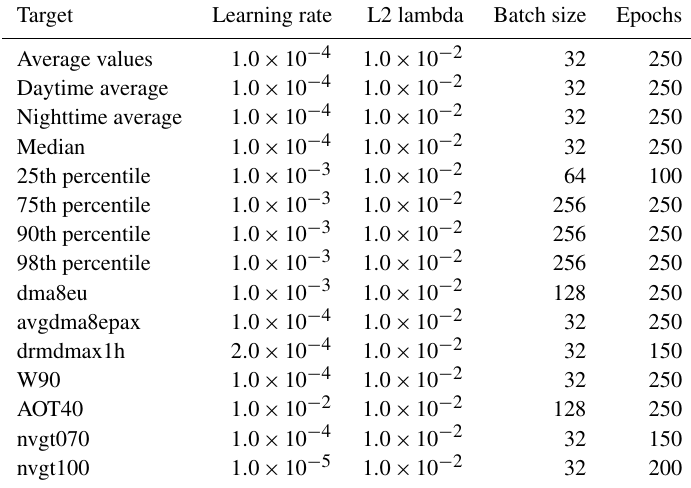
Table D1. Hyperparameters for the neural network training in Sect. 5.3. They are determined from empirical studies and random